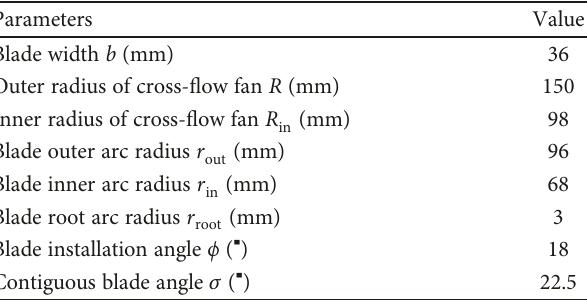
Table 2: Geometry of cross- fl ow fan blade parameters.